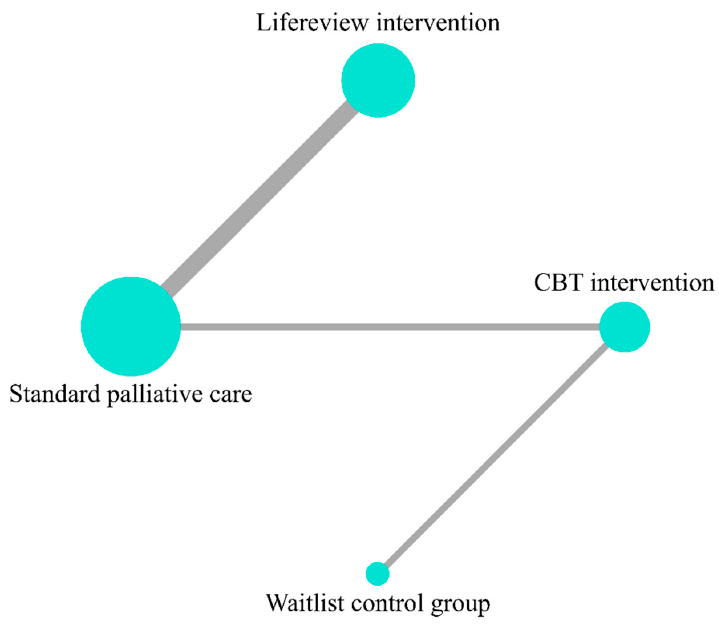
Figure 2. Network plot for outcome of HADS total.